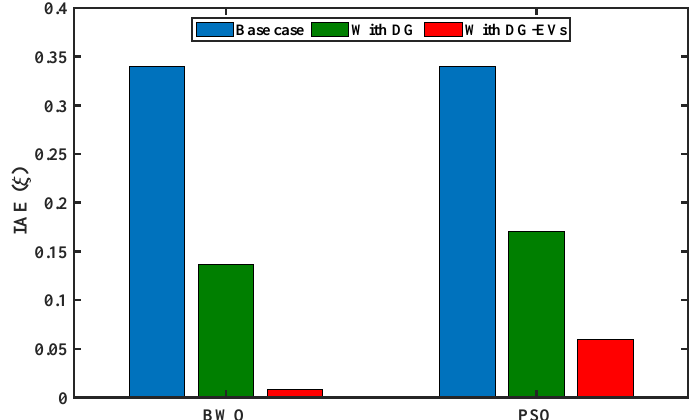
Figure 10. Integral absolute error using BWO and PSO.